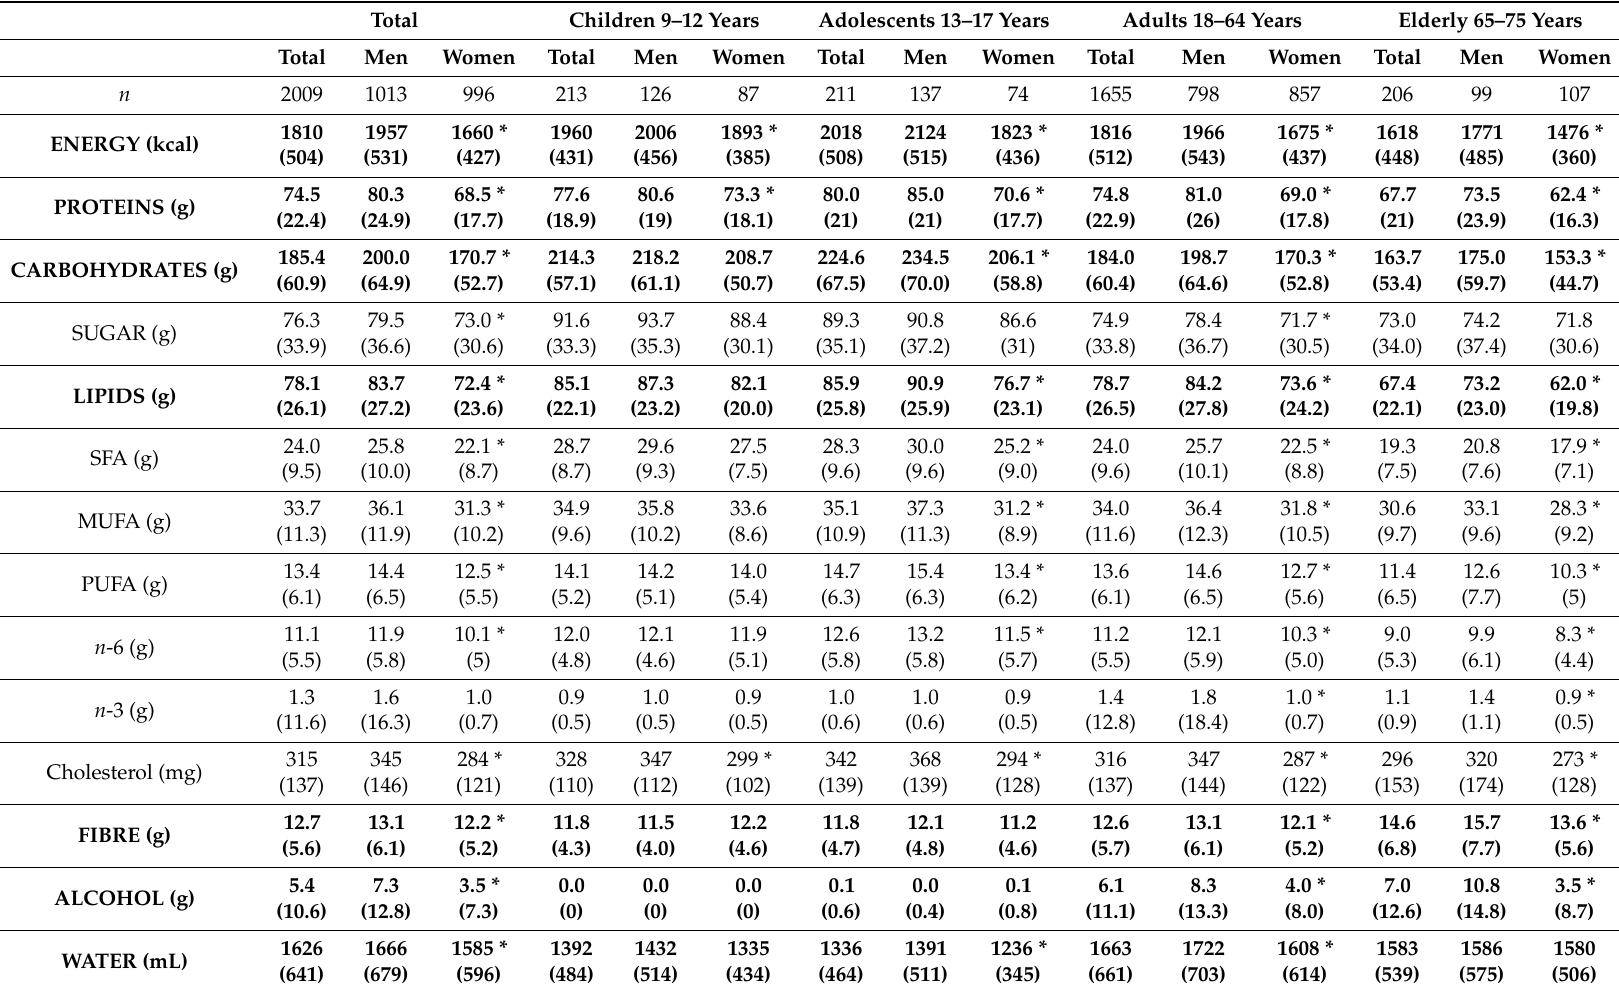
Table 2. Total daily nutrient intake by sex and age group in the Spanish ANIBES study population aged 9–75